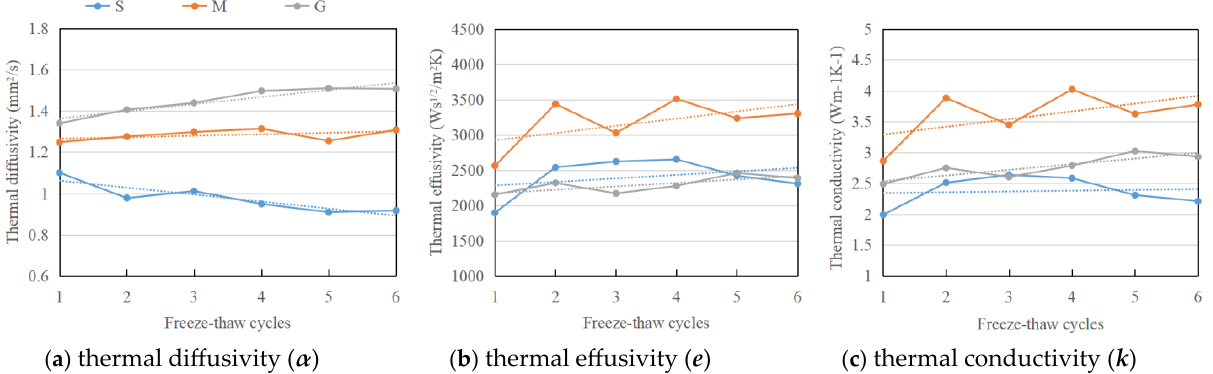
Figure 13. Variation of ( a ) thermal diffusivity ( b ) thermal effusivity and ( c ) thermal conductivity (solid line) with different freeze–thaw cycles, and the trend (dash line). The thermal diffusivity of sandstone drops from 1.10 mm 2 /s to 0.92 mm 2 /s with the freeze–thaw cycles, while for marble and granite samples, the thermal diffusivity slightly